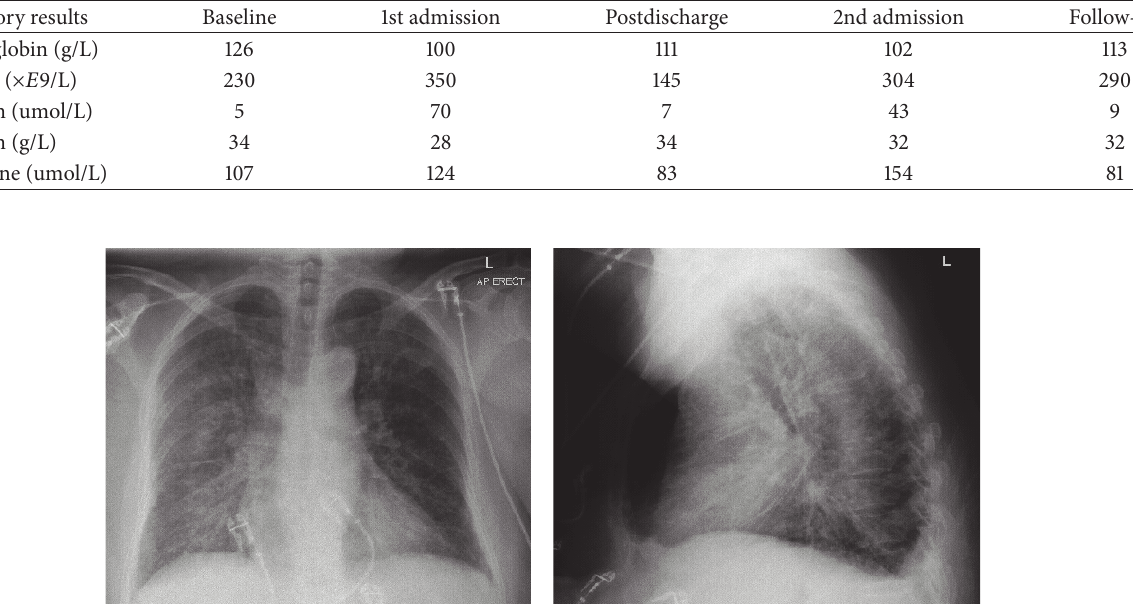
Table 1: Baseline and subsequent laboratory results.